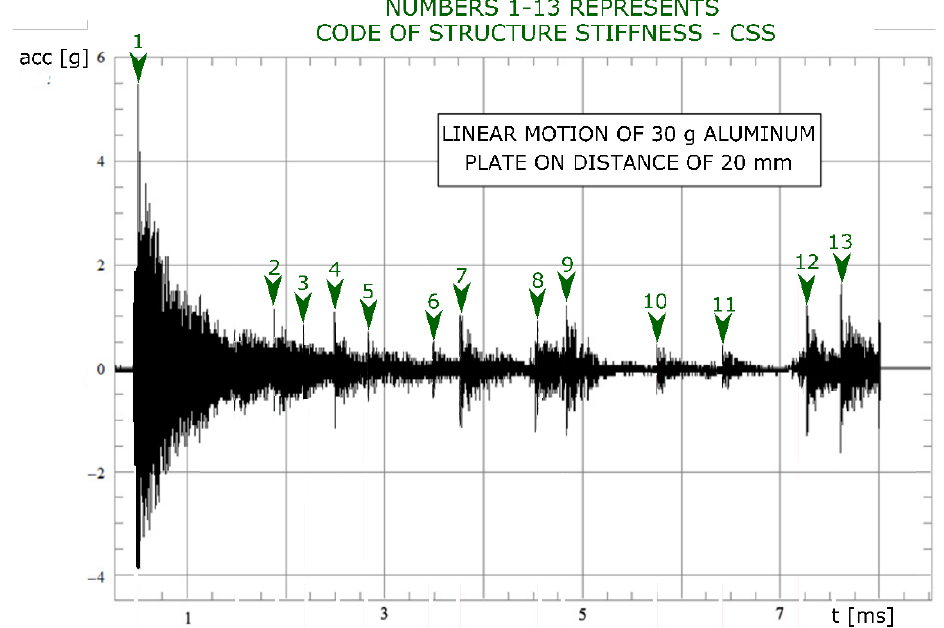
Figure 4. Decoded signals from ICP sensor, where the numbers from 1 to 13 represent code of the structure stiffness (CCS).